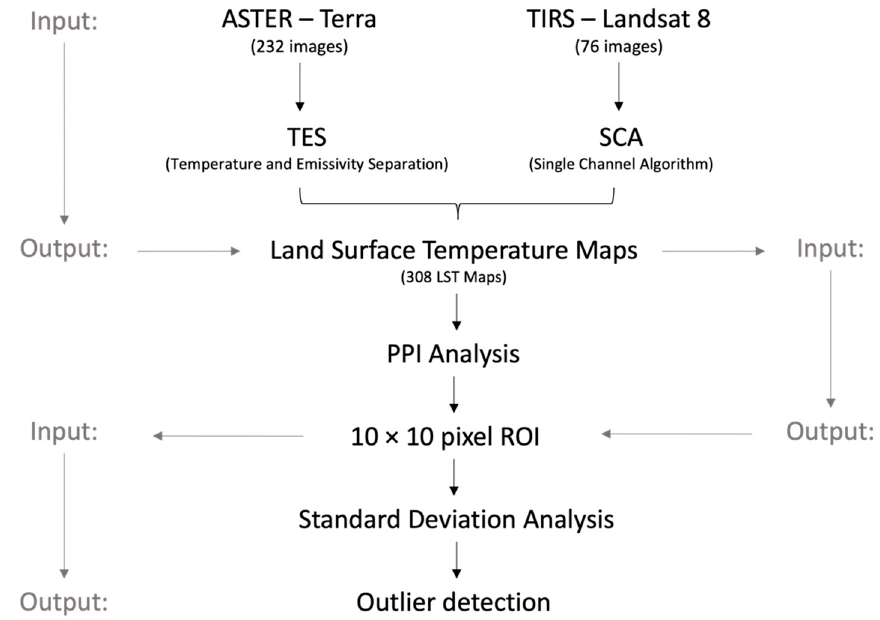
Figure 8. Workflow and steps of the process adopted to individuate the outlier.